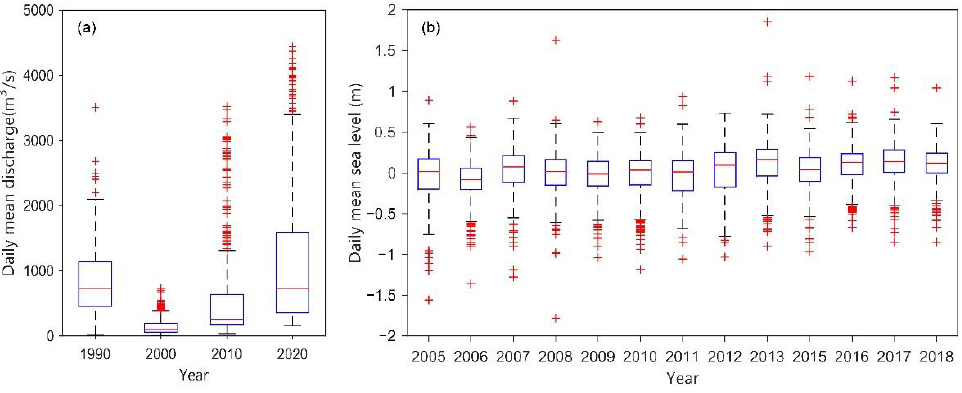
Figure 8. ( a ) Box chart of river discharge of Lijin Station from 1990 to 2020, and ( b ) box chart of daily average tide level of Gudong Station from 2005 to 2018.